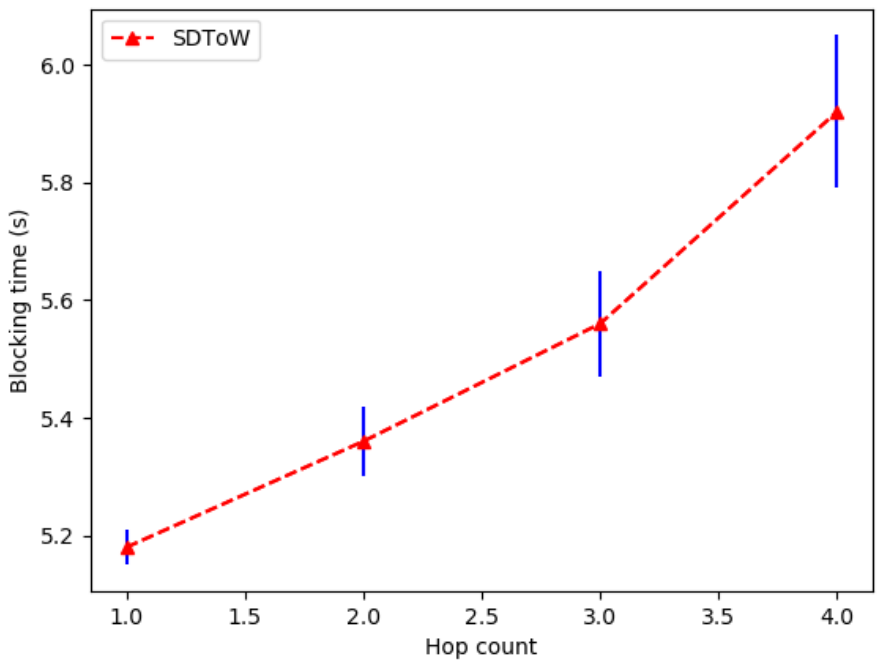
Figure 9. The influence of the number of hops on the total blocking